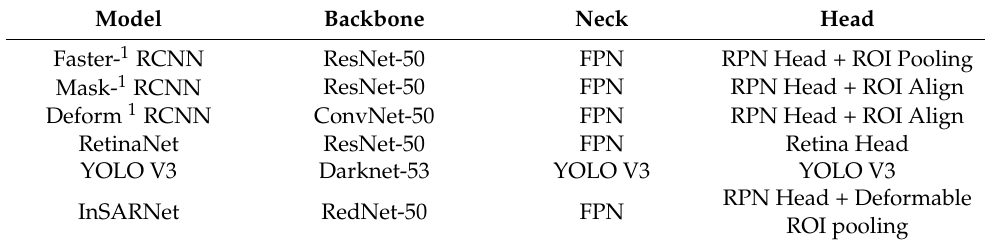
Table 7. Detection models and their structures.